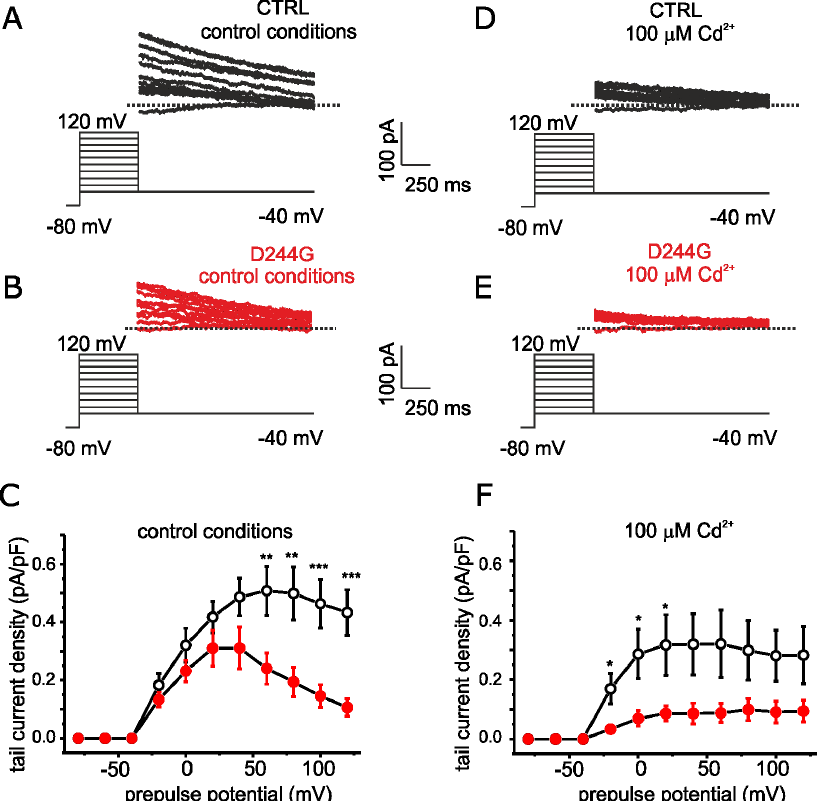
Fig 5. SK tail current densities in control vs D244G expressing myotubes. Sample tail currents elicited by pre-pulse potentials from -40mV to +120mV and recorded at a holding potential of -40 mV from control ( A , black traces ) and D244G expressing ( B , red traces ) myotubes. ( C ) Tail current densities, calculated from control ( open circles ) and D244G ( red circles ) myotubes and, plotted as a function of pre-pulse potentials. Sample tail currents recorded as described above in the presence of Cd 2+ (100 μ M), from control ( D , black traces ) and D244G ( E , red traces ) myotubes. ( F ) Tail current densities in the presence of Cd 2+ (100 μ M) that were recorded, calculated and plotted as described in C. Data reported in plots C and F were obtained from 3 independent experiments (n = 6; * p < 0.05; ** p < 0.01; *** p <